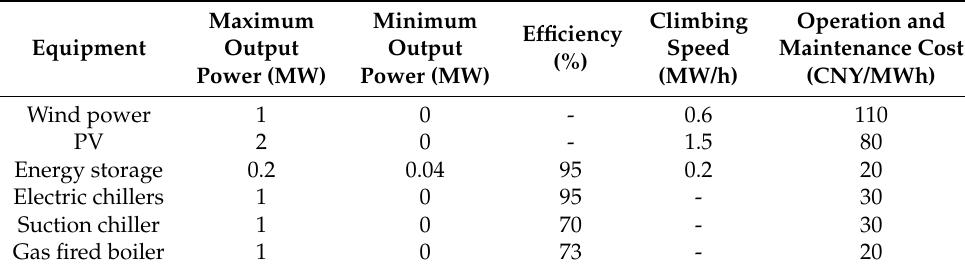
Table 2. Technical and economic parameters of wind and solar storage and electric chiller.